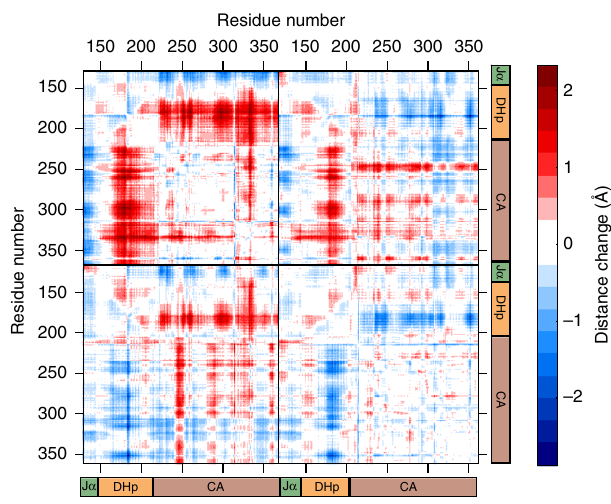
Fig. 5 C α double distance difference matrix. The difference in C α distance changes between YF1 int. and YF1 fi